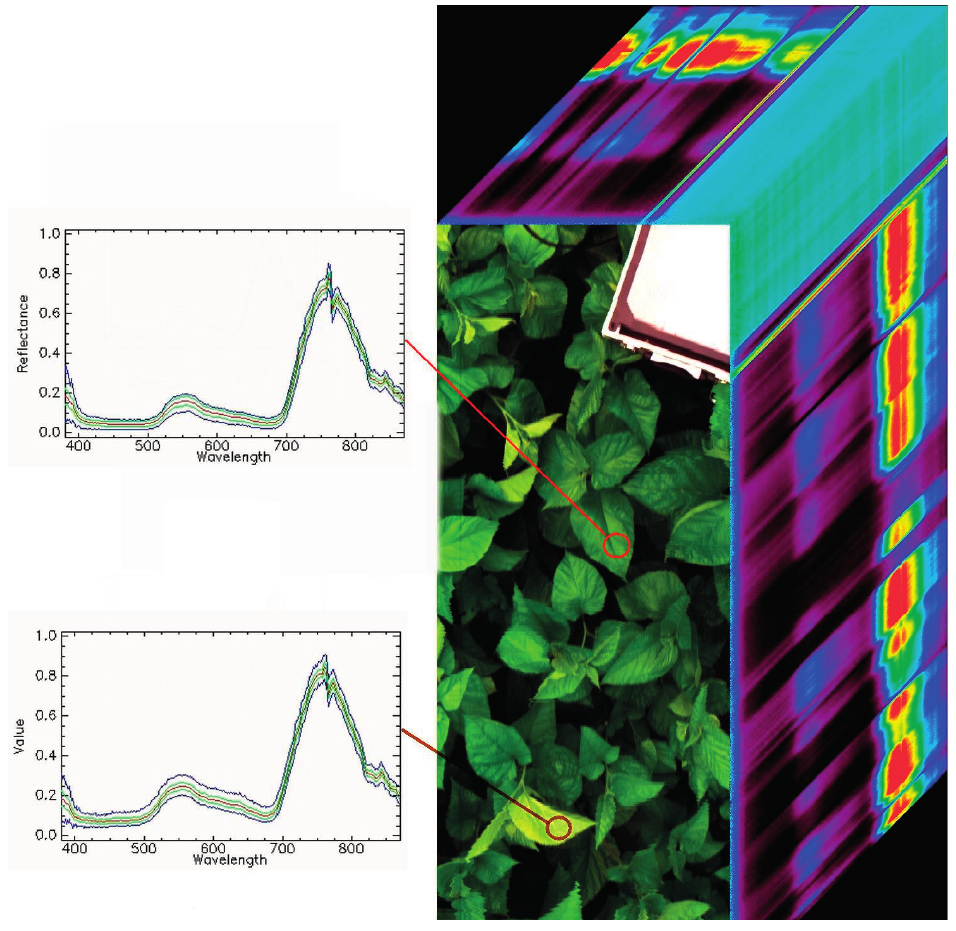
Figure 4. A sample of the hyperspectral data cube obtained by